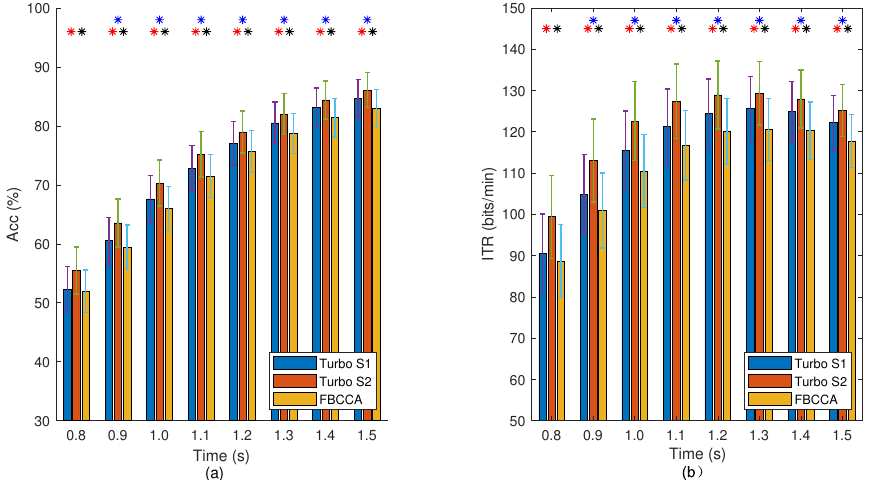
Figure 5. The average results of 35 subjects in the benchmark datasets. ( a ) Average classification accuracy of FBCCA and turbo detector with different data lengths. ( b ) Average ITR of FBCCA and turbo detector with different data lengths. The error bars represent the standard error. * indicates significant difference between two methods by paired t -test (* p < 0.05)